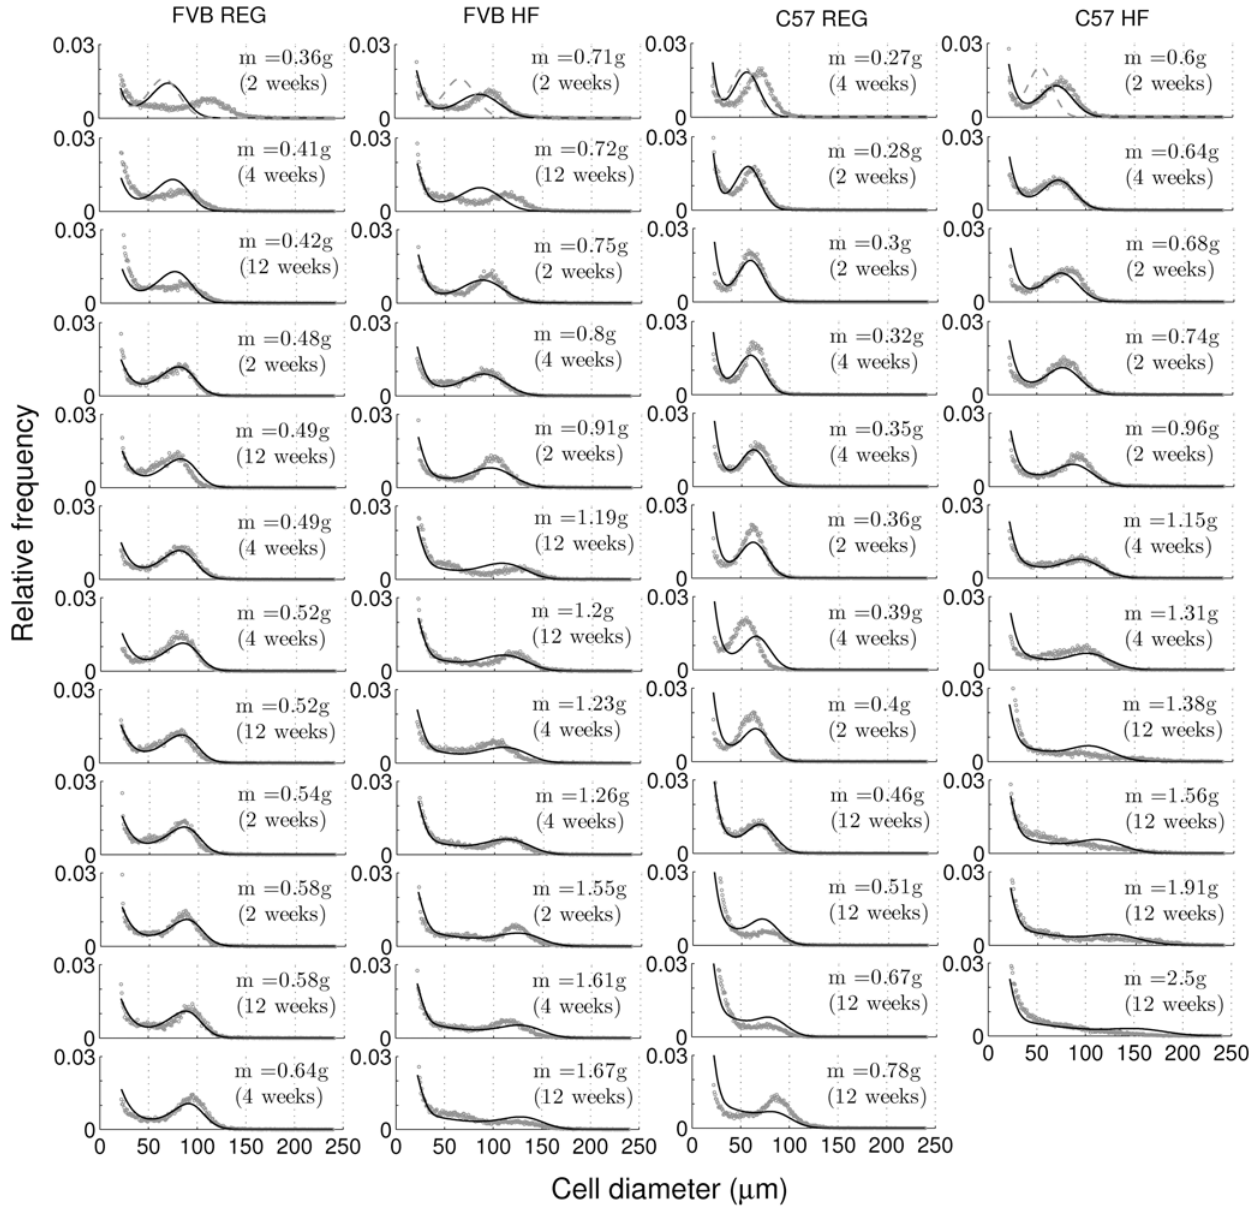
Figure 5. Changes of cell-size distributions with the mass increase of epididymal fat pad under chow and high-fat diets. Initial cell- size distributions of five-week-old control mice are given at the first row of each column with dashed lines. Dots show experimental results. Note that the results are ordered with epididymal fat pad mass, not with the chronological time (weeks of controlled feeding) shown in parentheses. Solid lines represent the normalized cell-size distributions corresponding to the given epididymal fat pad mass, predicted by the adipose tissue growth model.